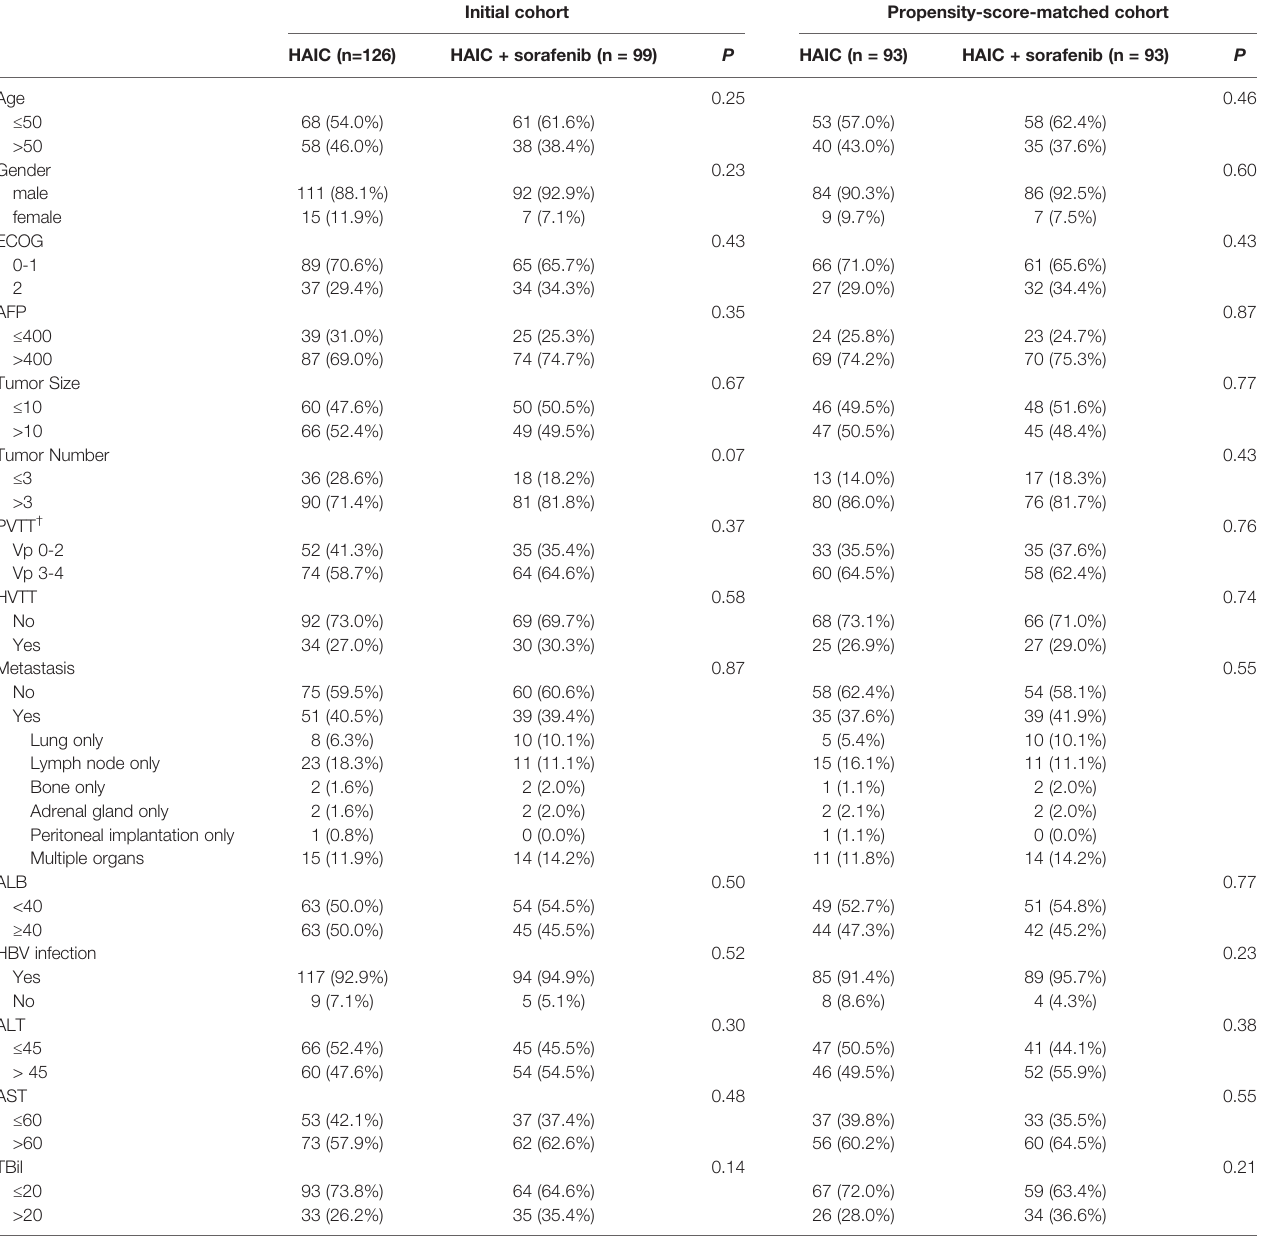
TABLE 1 | Patient baseline demographic and clinical characteristics. Initial cohort Propensity-score-matched